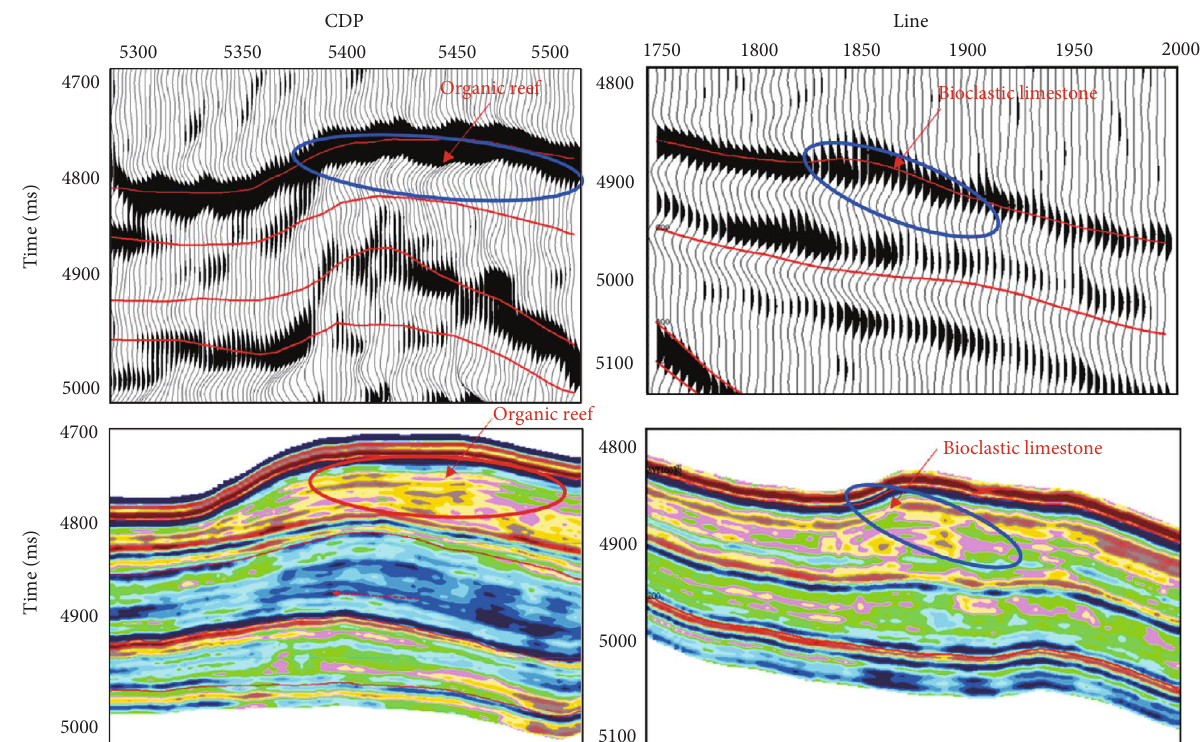
Figure 12: The acoustic impedance inversion pro fi le of the organic reef and bioclastic limestone